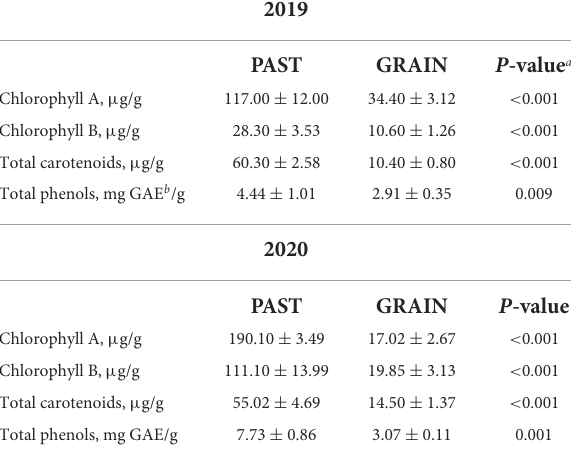
TABLE 2 Antioxidant profile of pasture and grain